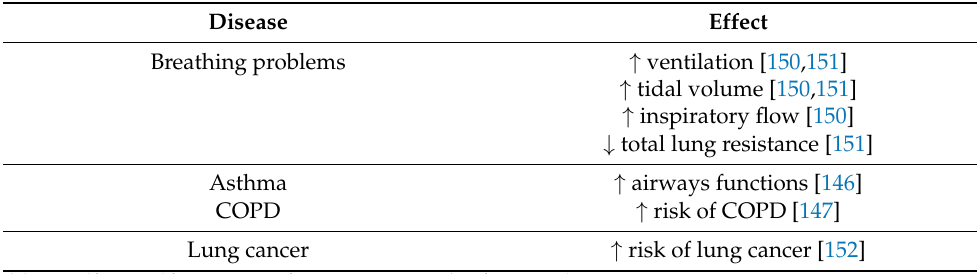
Table 2. The effects of caffeine action in respiratory system